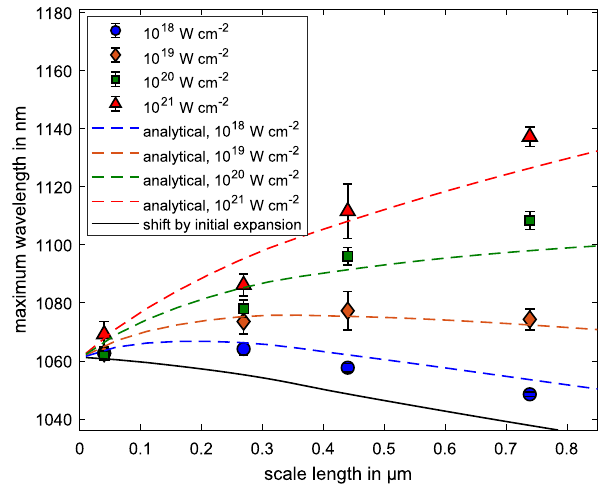
Fig. 2 Correlation of maximum wavelength and scale length. Maximum wavelength of the re fl ected spectrum extracted from the 2-D PIC simulations for different preplasma scale lengths and maximum laser intensities (colored shapes). The uncertainties are given by the peak-to- valley difference between the maximum wavelength at 1 and 10% of the maximum spectral intensity. The colored dashed lines represent the maximum wavelength that has been calculated from the maximum holeboring velocity with equation (2), which is corrected by the initial shift of the preplasma expansion (black line). The initial maximum wavelength of the incoming laser pulse is given by λ max ¼ 1061